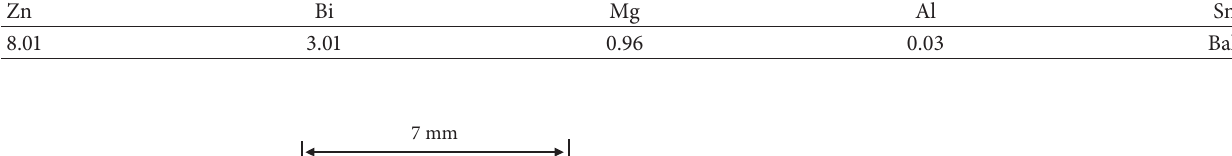
8 Zn 3 Bi 1 Mg active solder (wt.%).